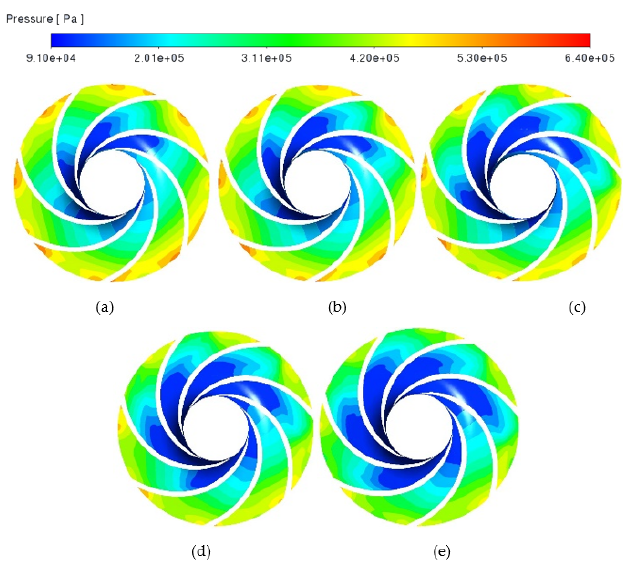
Figure 7. Pressure distribution of the primary impeller. ( a ) NPSH a = 9 m; ( b ) NPSH a = 7 m; ( c ) NPSH a = 6 m; ( d ) NPSH a = 5 m and ( e ) NPSH a = 4 m.